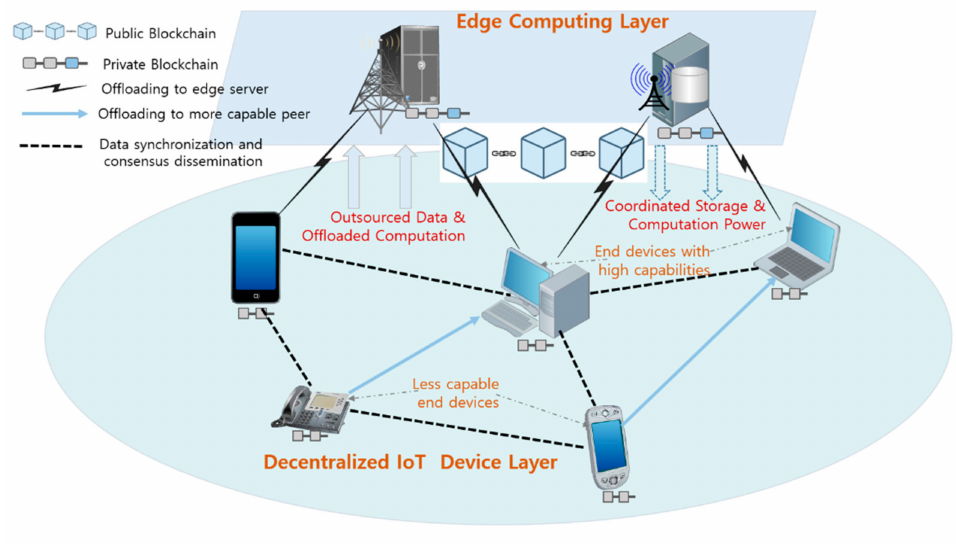
Figure 5. Operations involved in the IoT device